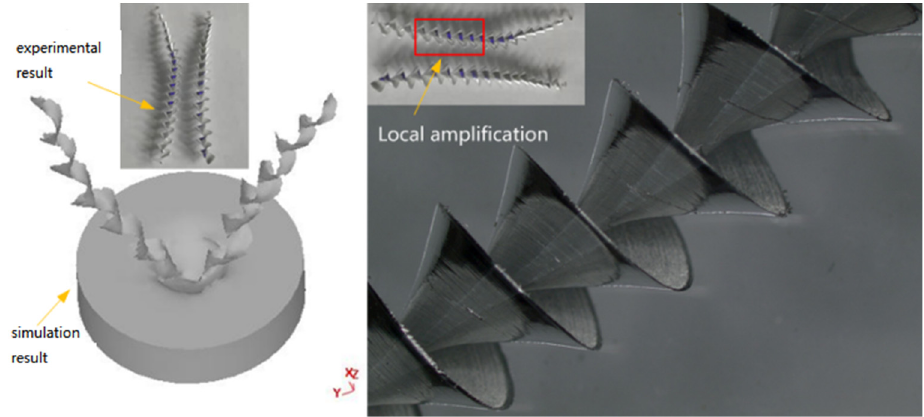
Figure 18. Formation and comparison of chips during experiment and simulation.